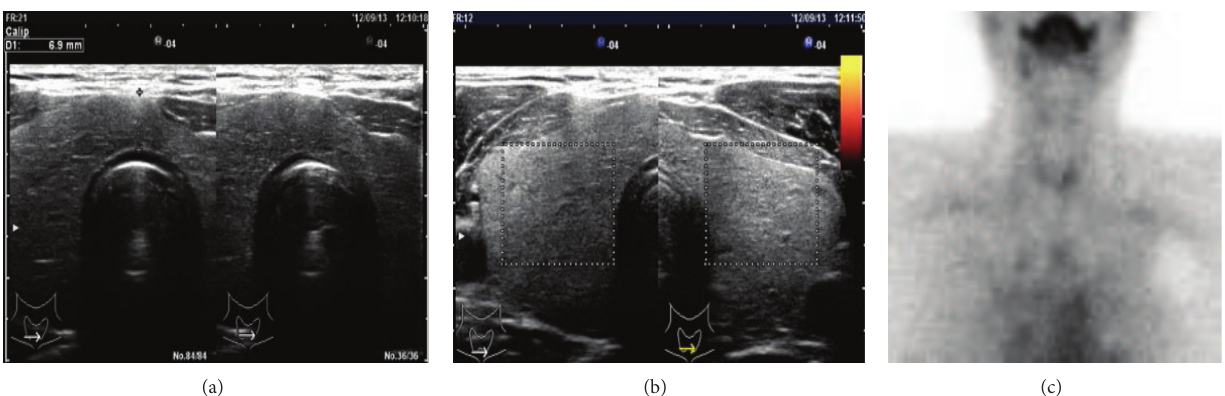
Figure 2: (a) Ultrasonic study of the thyroid revealing mild swelling with 6.9 mm isthmus diameter. (b) Doppler flow study of the thyroid gland revealing no blood flow increase. (c) Thyroid 99 m Tc scintigraphy revealing no